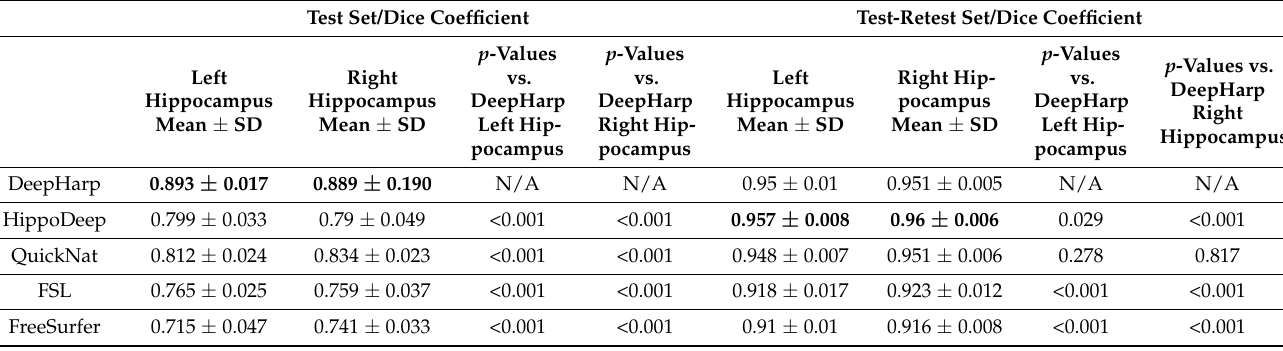
Figure 7. Comparison of DeepHarp robustness (based on Dice score) with common tools and state ‐ of ‐ the ‐ art methods for hippocampus segmentation.